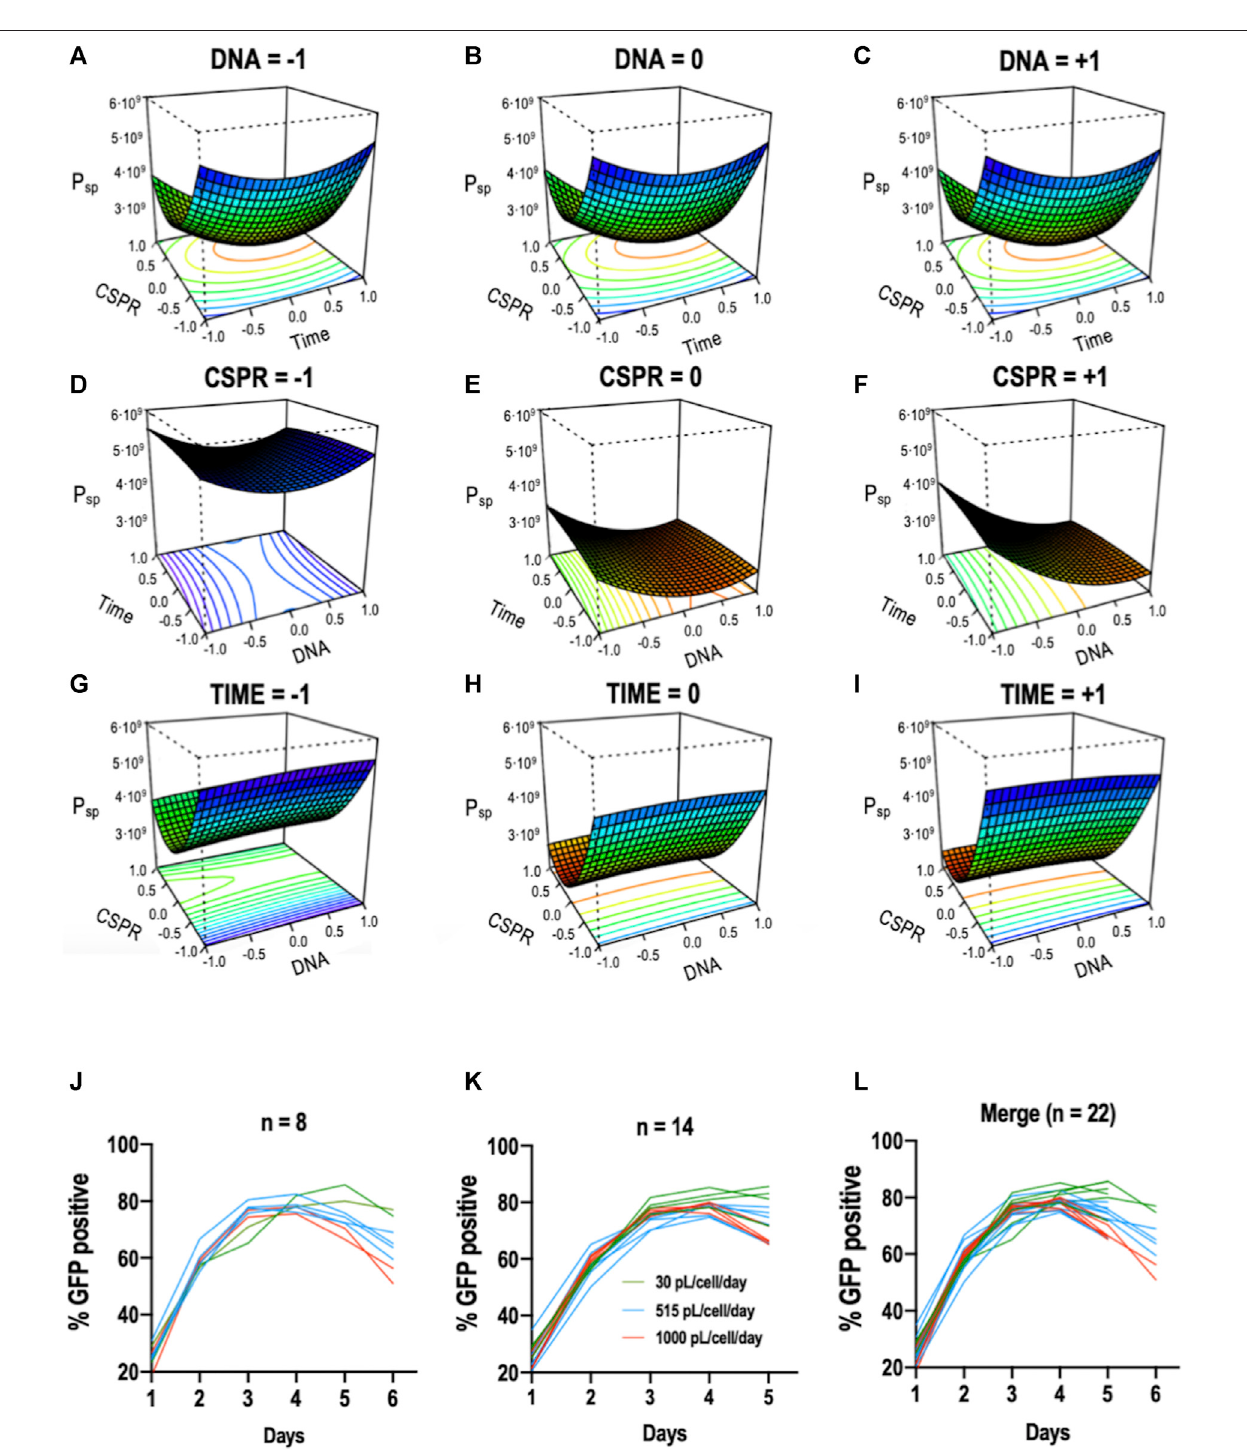
FIGURE2| Response surfacegraphsbasedon Box-Behnken experimentalresults. MaximumVLPspeci fi cproduction incell culturesupernatantsasafunctionof (A-C) CSPRvs.Time; (D-F) timevs.DNA;and (G-I) CSPRvs.DNA.Thegraphswereconstructedbydepictingtwovariablesatatimeandmaintainingthethirdoneata fi xed level. +1, 0, and − 1 correspond to 0.5, 1.25, and 2 mg/ml for the DNA concentration; 30, 515, and 1000 pL/cell/day for the CSPR and 24, 48, and 72 hpt for the timeofretransfection. (J-L) representthechangesofthepercentageoftransfectionmeasuredinpercentageofGFPpositivecellsalongthestudiedtimecoursefor conditions reaching the sixth day of the process (J) and conditions reaching the fi fth (K) . (L) Shows the merged plot.